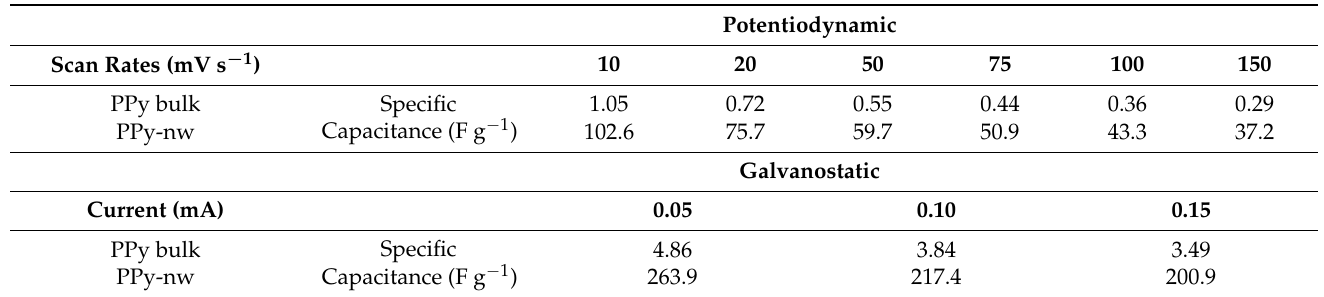
Table 2. Effect of electrode structure on calculated specific capacitance. Potentiodynamic